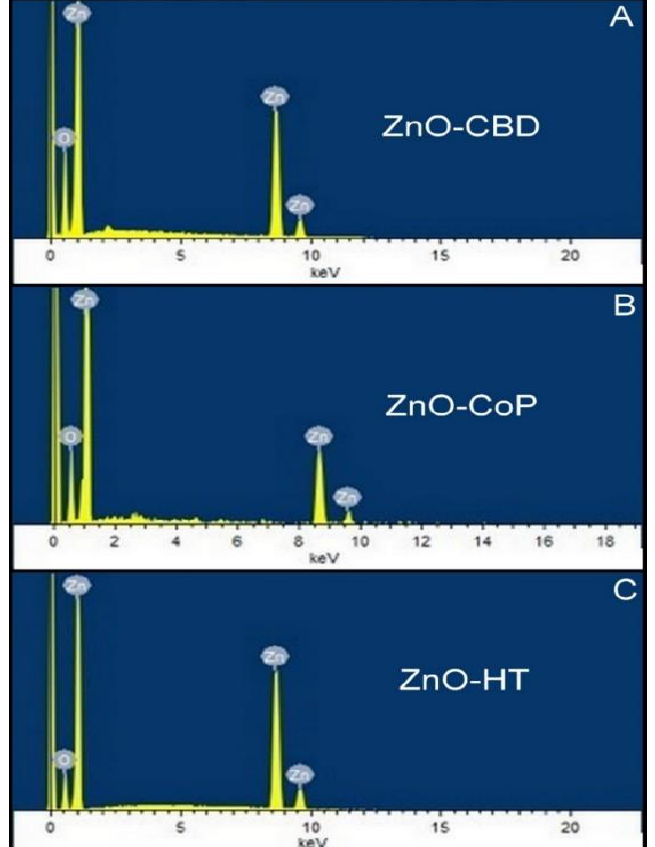
Figure 15. EDX spectra of ZnO grown via the HT, CoP and CBD methods (( A )—CBD, ( B )—CoP, ( C )—HT).